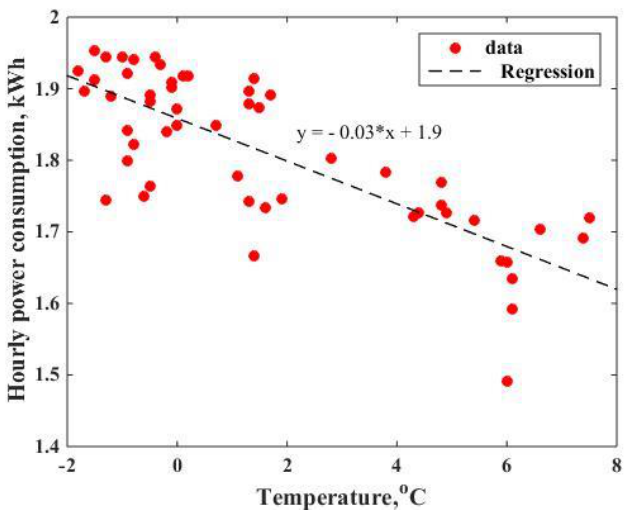
Figure 3. Power consumption of Eco-cute under different out